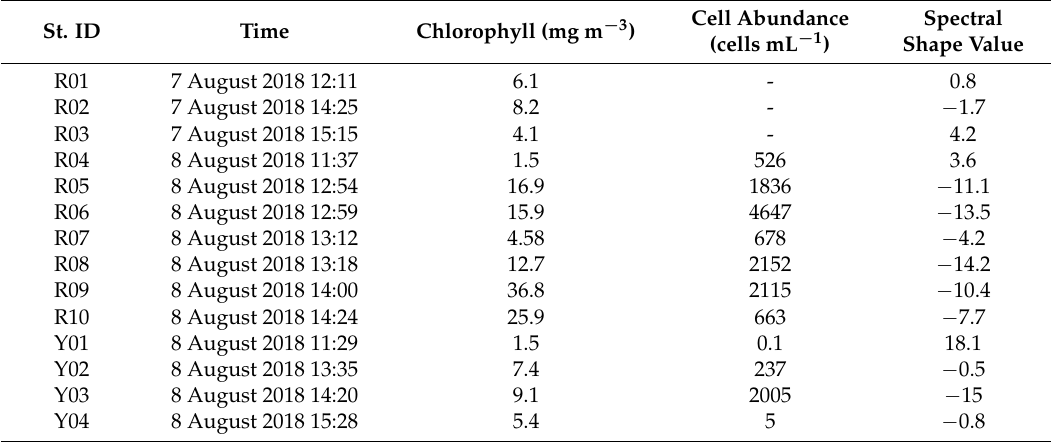
Table 4. In situ measurements of CHL and Margalefidinium cell abundance at each sampling location in the study area (Spectral Shape value was estimated from the spectra at 443, 490, and 570 nm for each sampling